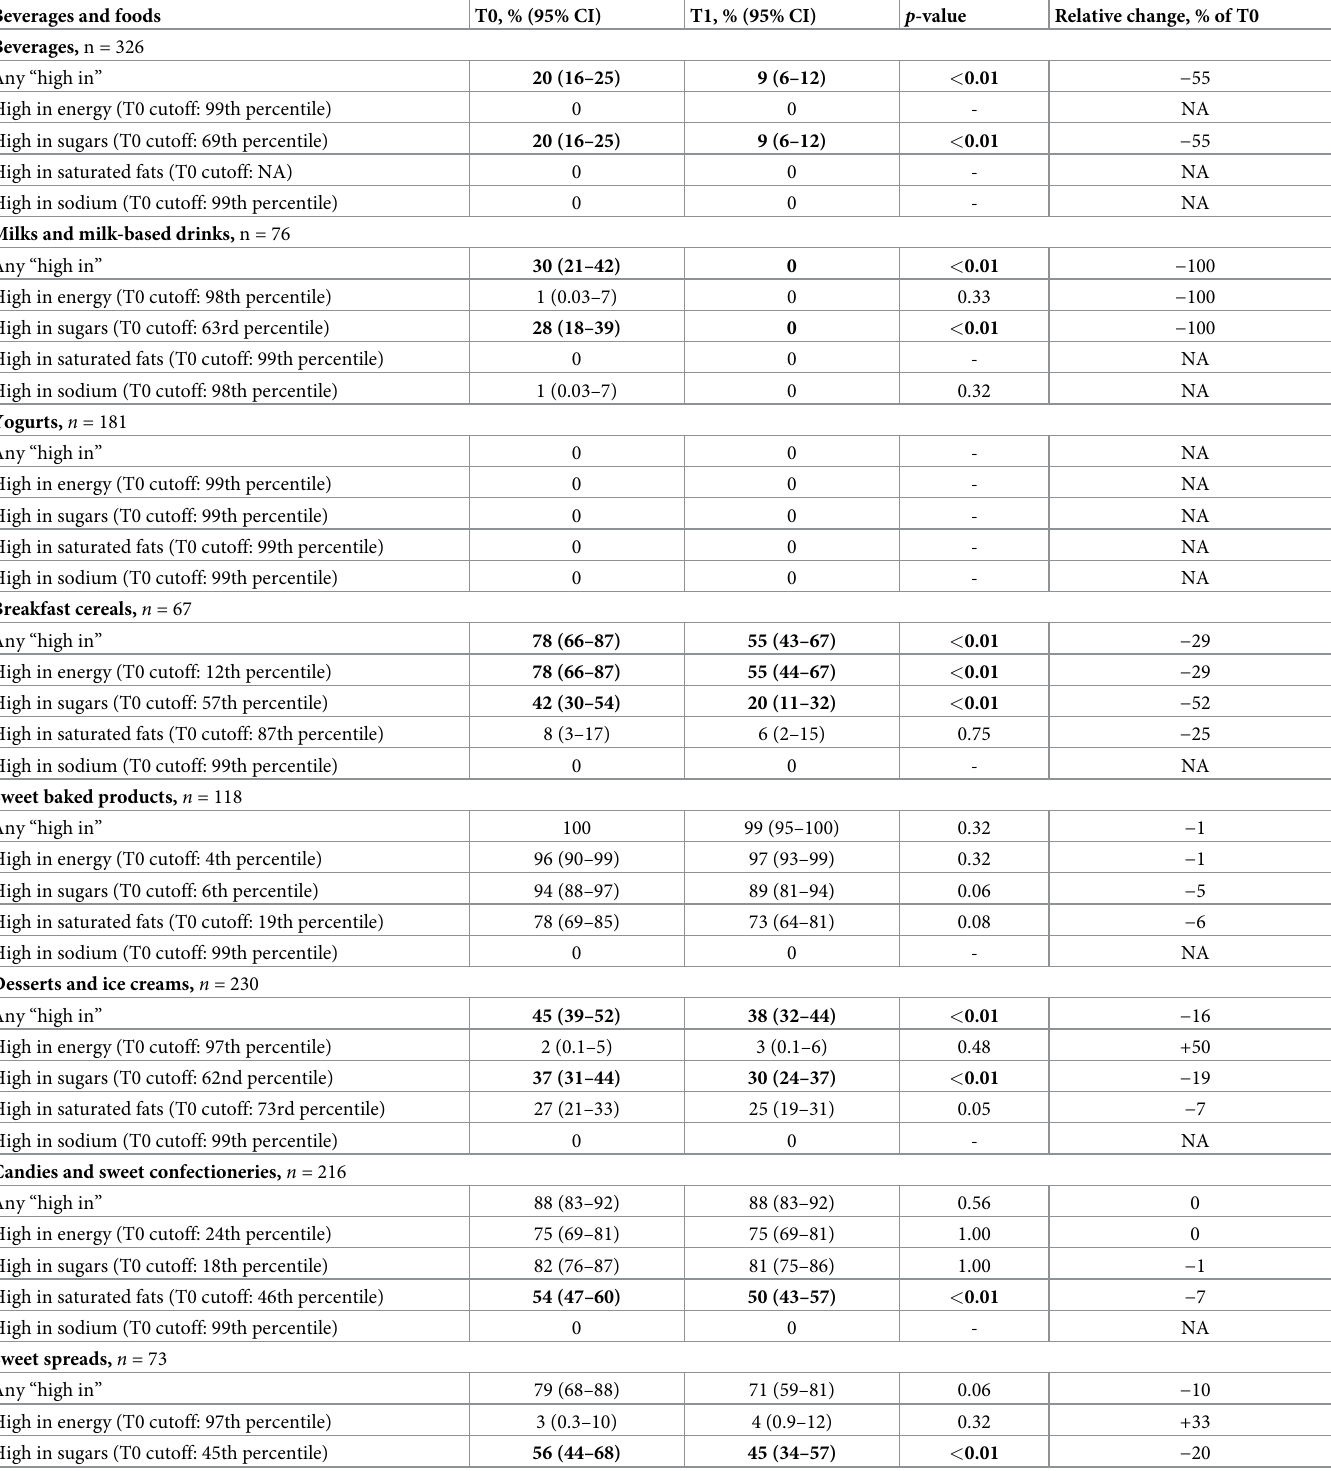
Table 3. Changes between T0 and T1 in the proportion of “high in” energy and nutrients of concern (or any “high in”) by food or beverage group, longitudinal analysis. Beverages and